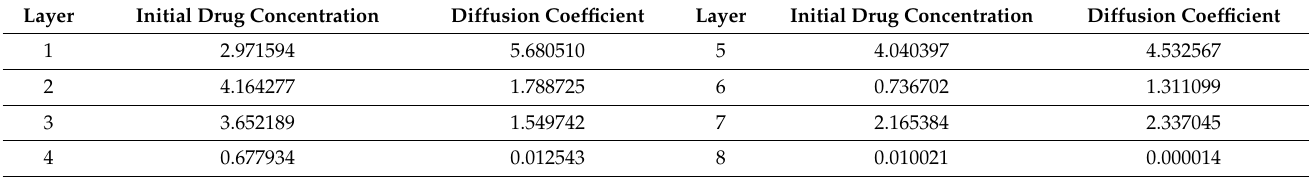
Table 8. The initial drug concentration and diffusion coefficient at each layer of the drug-controlled release model for NL = 8 (Case 1).